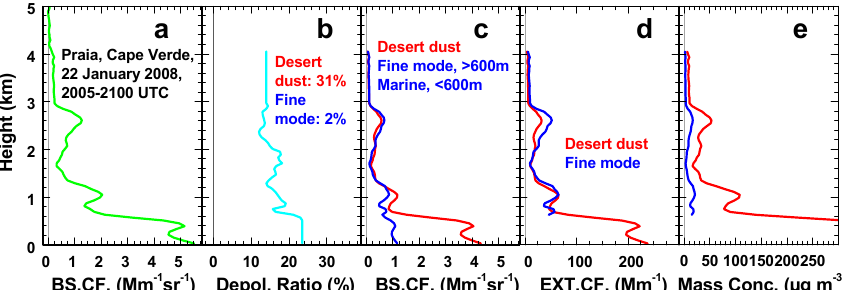
Fig. 3. Same as Fig. 2 except for a SAMUM-2 lidar observation at Praia (90ma.s.l.), Cape Verde, in January 2008. Composite profiles of backscatter and extinction coefficients and linear depolarization ratio are shown, derived from measurements with three lidars (Groß et al., 2011a,b; Tesche et al., 2011a,b). In (c) , > 600m and < 600m refer to the height range above and within the MBL with layer top height of 600m,